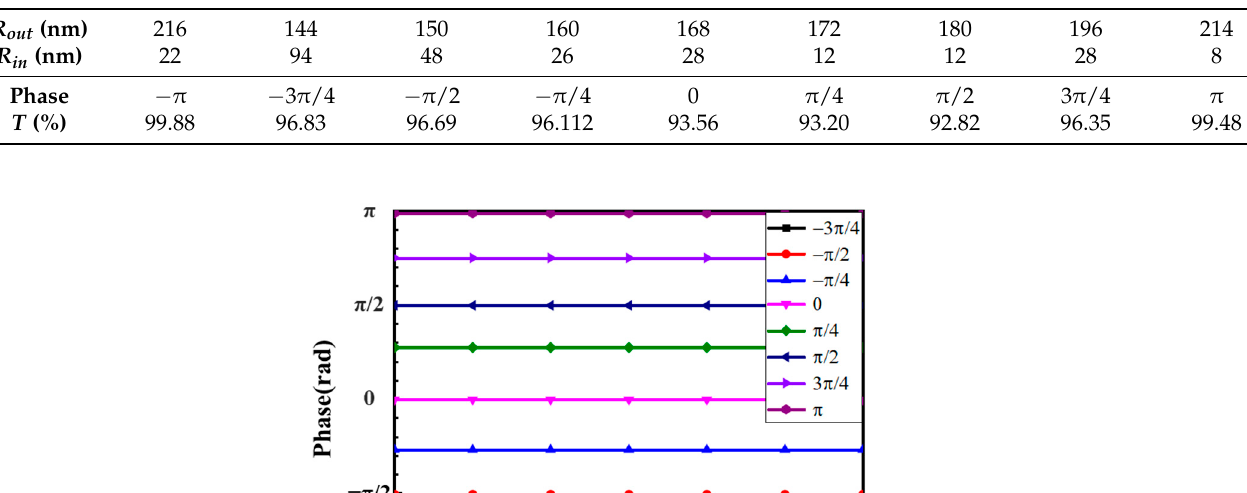
Figure 3. The transmittance T and the phase delay φ caused by the Si nano-rings with different combination of the outer and inner radiuses at the wavelength of 1550 nm. ( a ) The transmittance of the nano-ring arrays; ( b ) the phase delay of the nano-ring arrays. Table 1. The transmittance and phase delay with the various inner and outer radiuses.